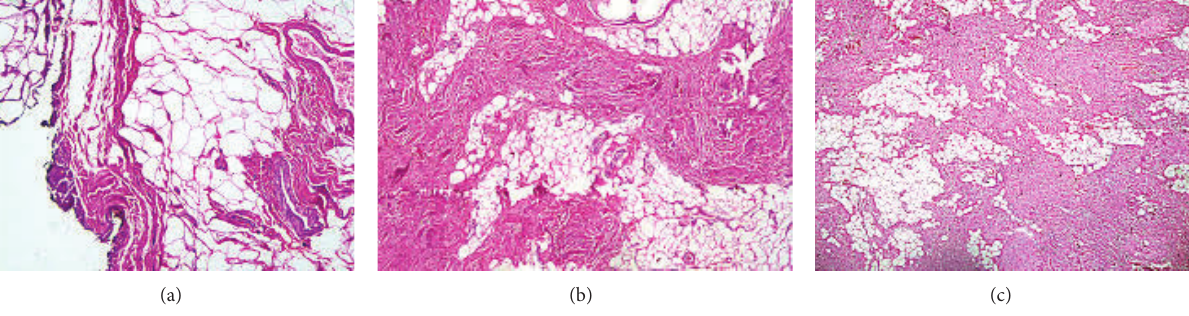
Figure 2: Thin fibrous capsule (H&E, × 200) (a) and a large number of eosinophilic globules, elastic fibers, and collagen mixed tapes and mature adipose tissue, centrally and peripherally (H&E, × 200) (b,